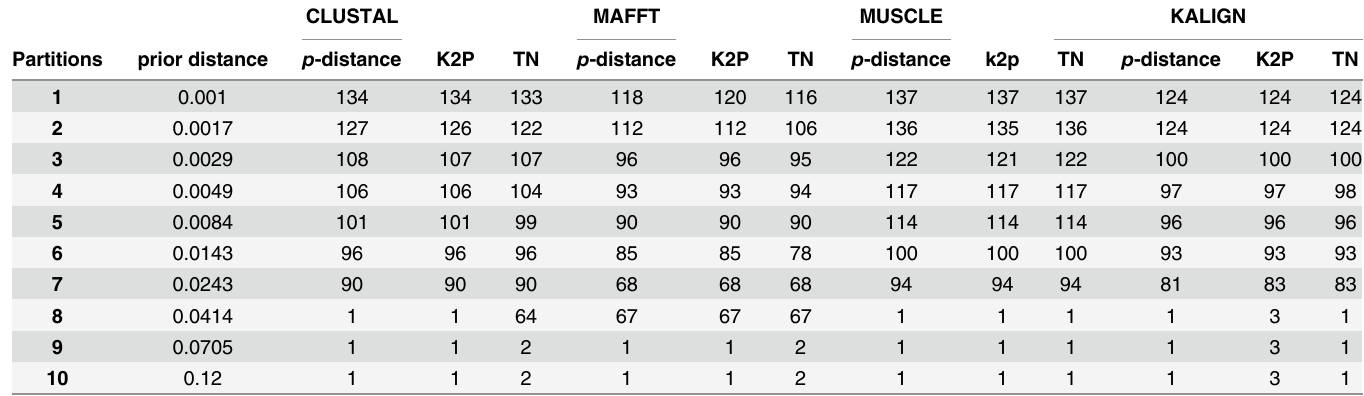
Table 3. ABGD analysis statistics. The number of operational taxonomic units is reported given the alignment algorithm, the genetic distance calculation methodology and the a priori established recursive intraspecific distance partitions in ABGD as a function of the prior limit between intra- and inter-specific divergence. p-distance, the proportion (p) of nucleotide sites at which two sequences being compared are different; K2P distance, Kimura ’ s 2-parameter dis- tance correction which takes into account transitional and transversional substitutions while assuming equal nucleotide frequencies and invariable substitu- tional rates among sites; TN, Tamura-Nei model based on variable base frequencies, equal transversion rates and variable transition